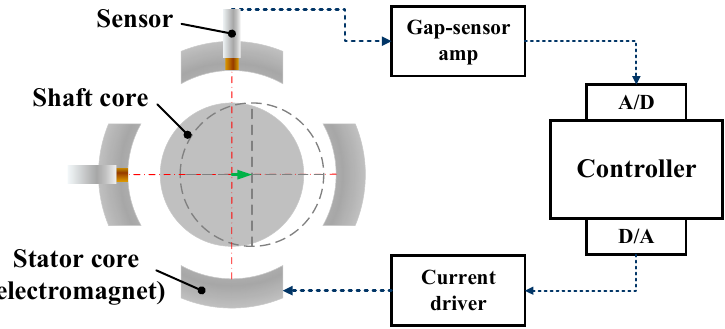
Figure 1. Schematic diagram of magnetic bearing control system.